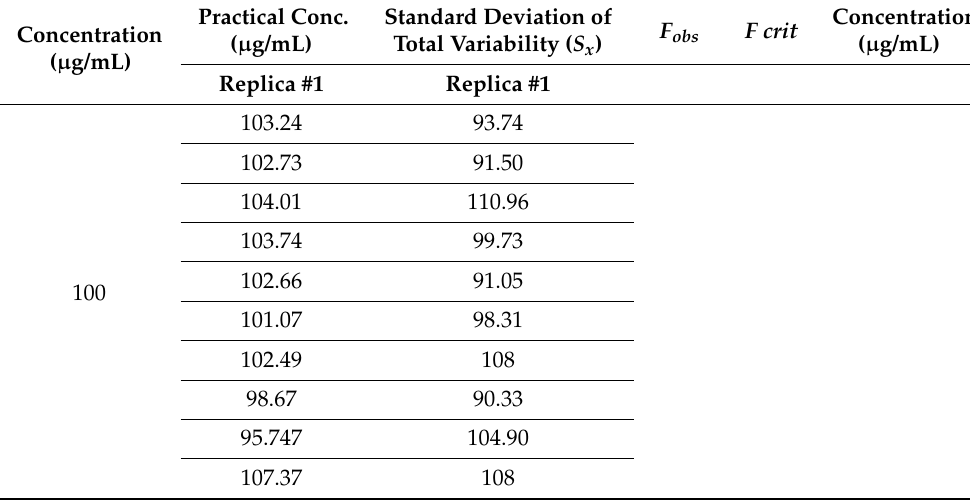
Table 4. Summary for the precision data of PPD in hair dye samples.